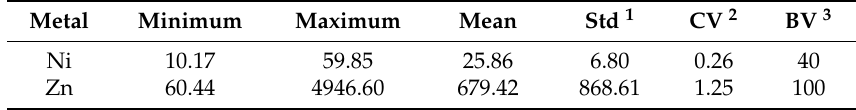
Table 1. Statistics of the collected soil samples for Ni and Zn concentrations (mg · kg − 1 ). Metal Minimum